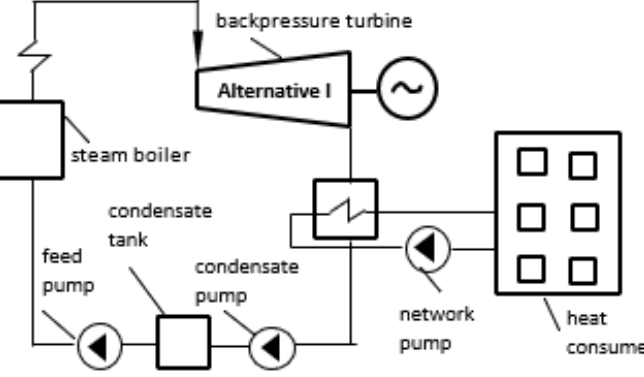
Figure 2. Schematic diagram of a CHP plant with a backpressure turbine.